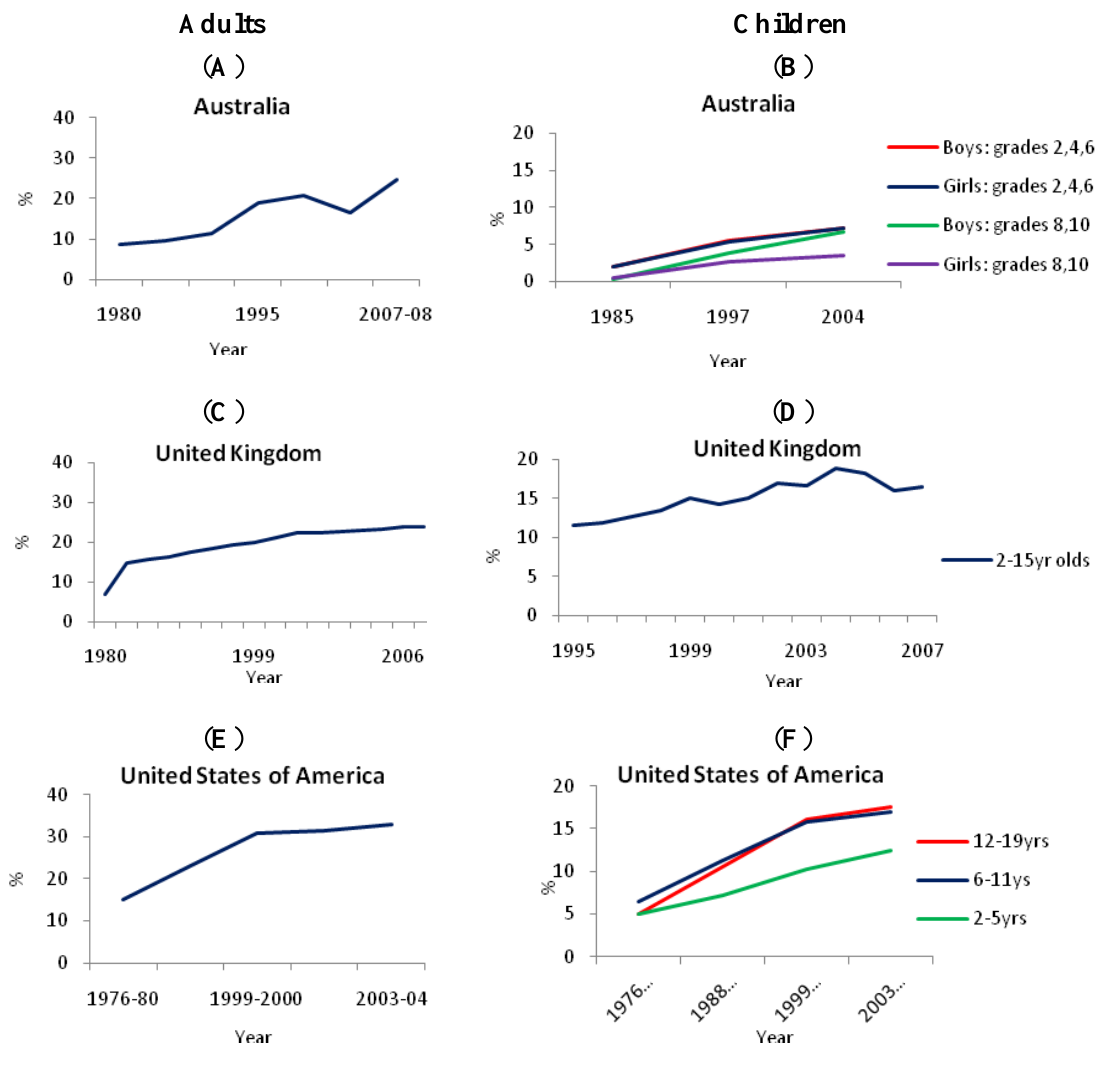
Figure 1. Prevalence of obesity (%) in ( A ) Australian adults, ( B ) Australian children, ( C ) adults in the United Kingdom, ( D ) children in the United Kingdom and ( E ) American adults ( F ) and children